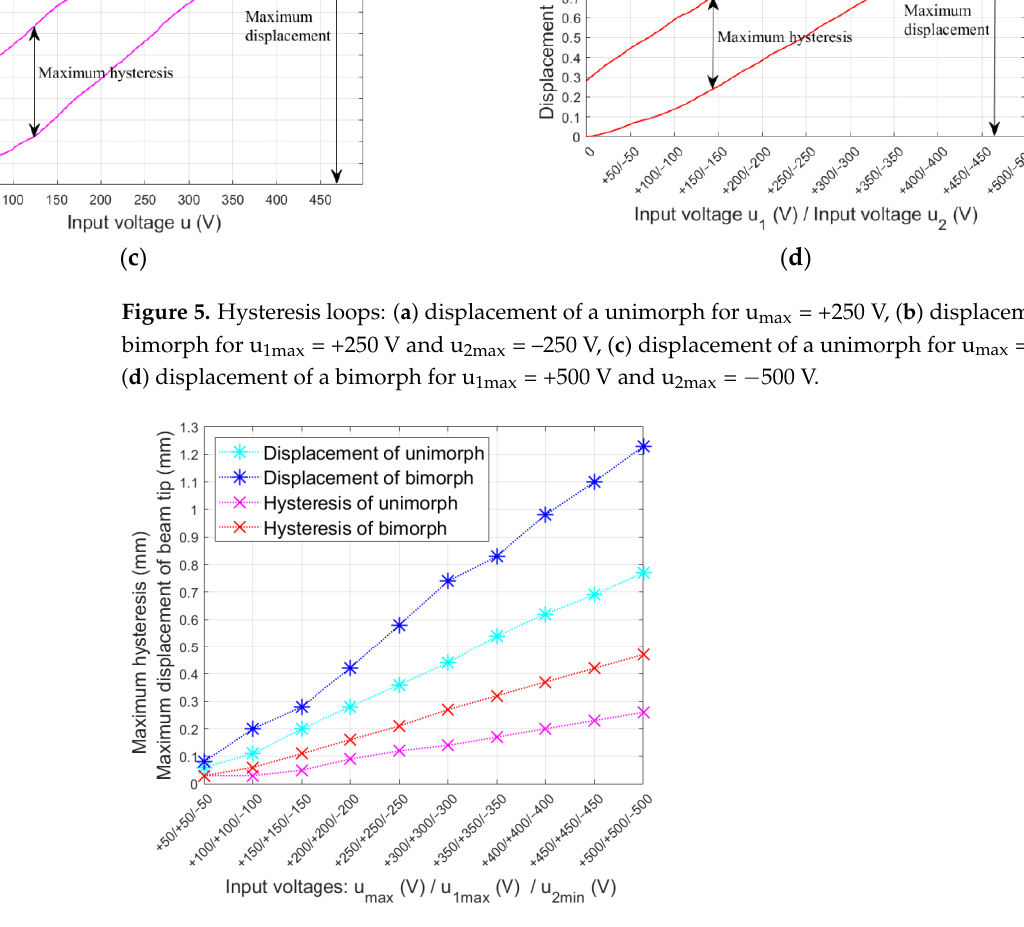
Figure 6. Comparison of the maximum displacement of the actuator beam tip and maximum hys- tereses.